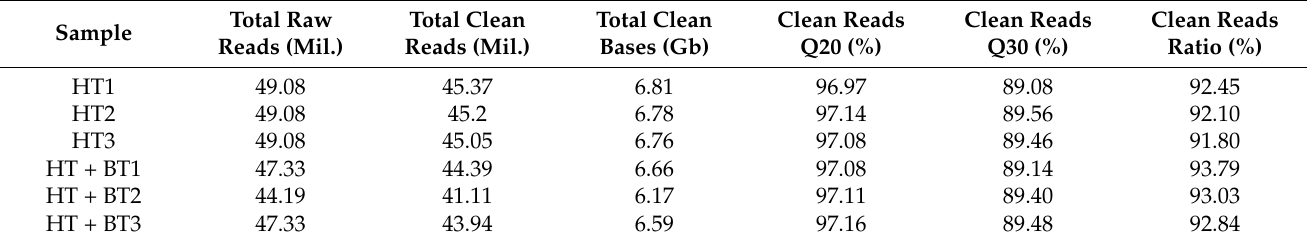
Table 2. Output and quality of sample sequencing data.